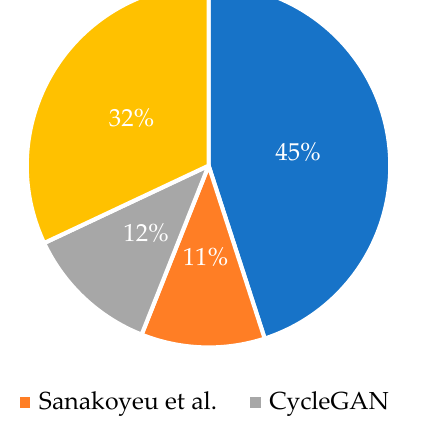
Figure 11. User preference voting for 4 algorithms.